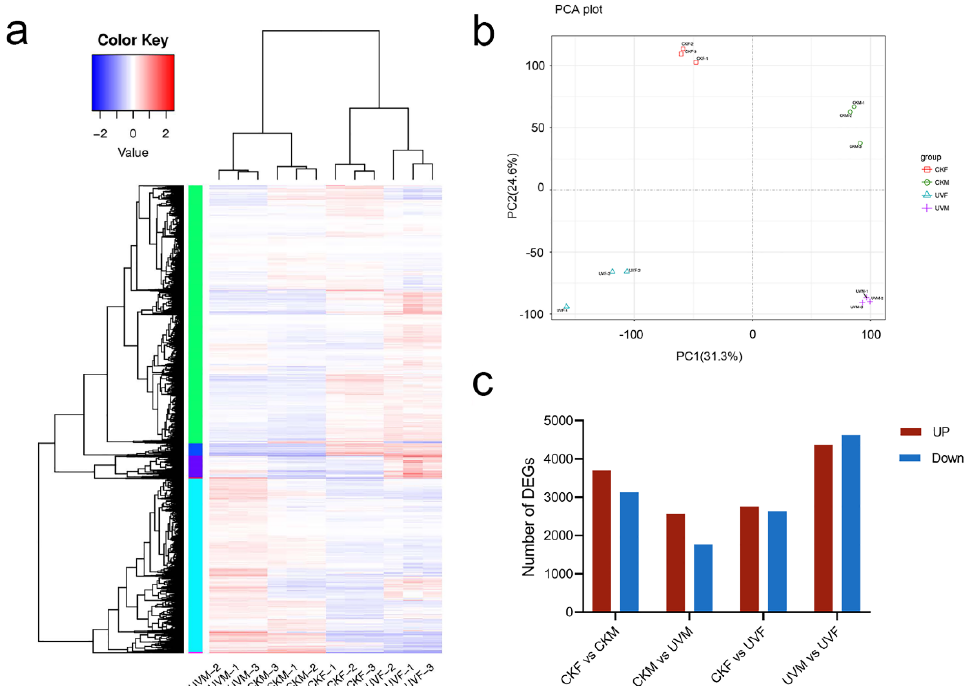
Figure 2. Differentially expressed genes (DEGs) between cmh15 and CM37 under control and salt stress conditions. ( a ) Heatmap showing the clustering of salt-stress responsive genes. ( b ) Principal component analysis of cmh15 and CM37 under control and salt treatment conditions. ( c ) DEGs detected in the 4 comparisons among the control and salt stress treatment groups.